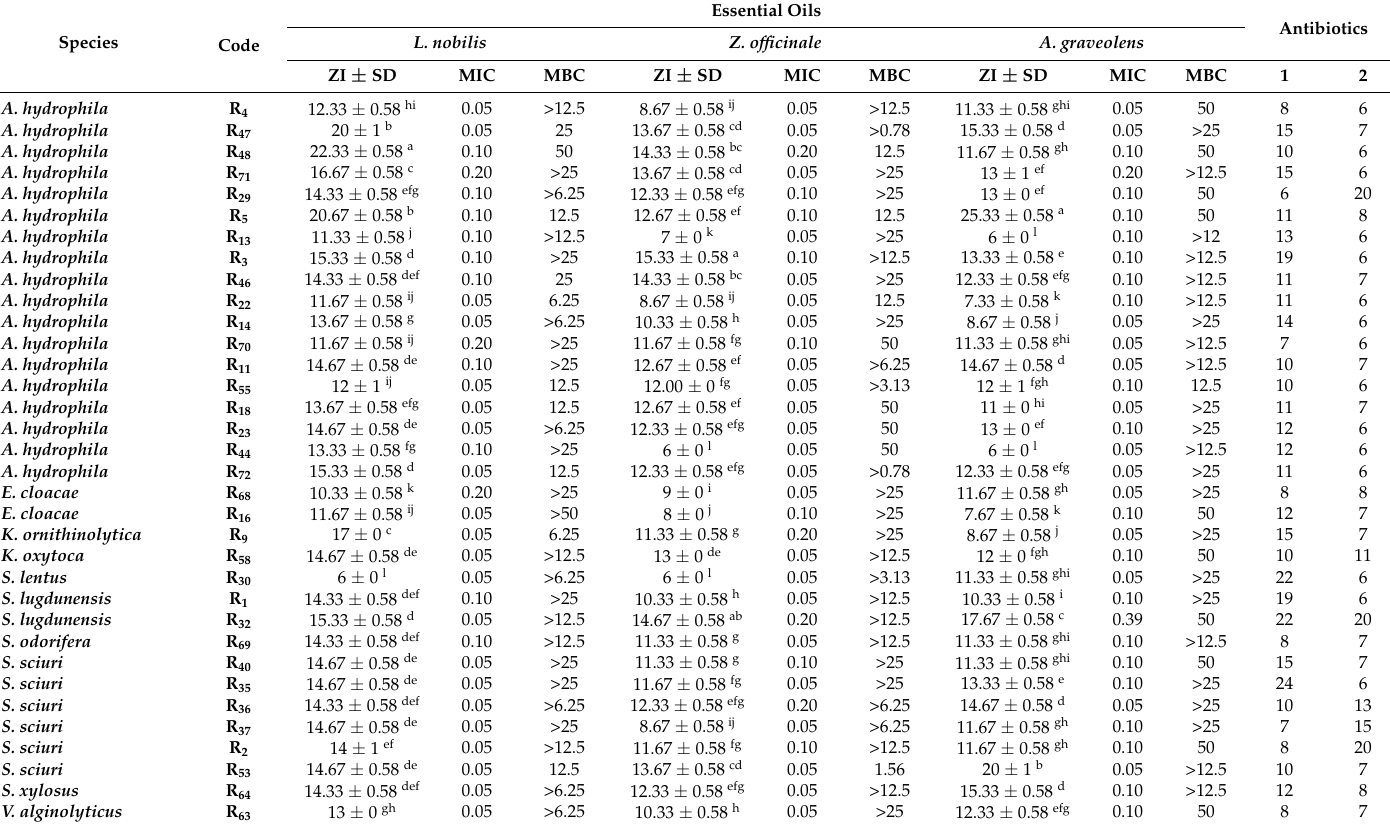
Table 4. Zone of growth inhibition (mean ± SD, mm), MICs and MBCs (mg/mL) caused by the three essential oils and by the standard antibiotics.